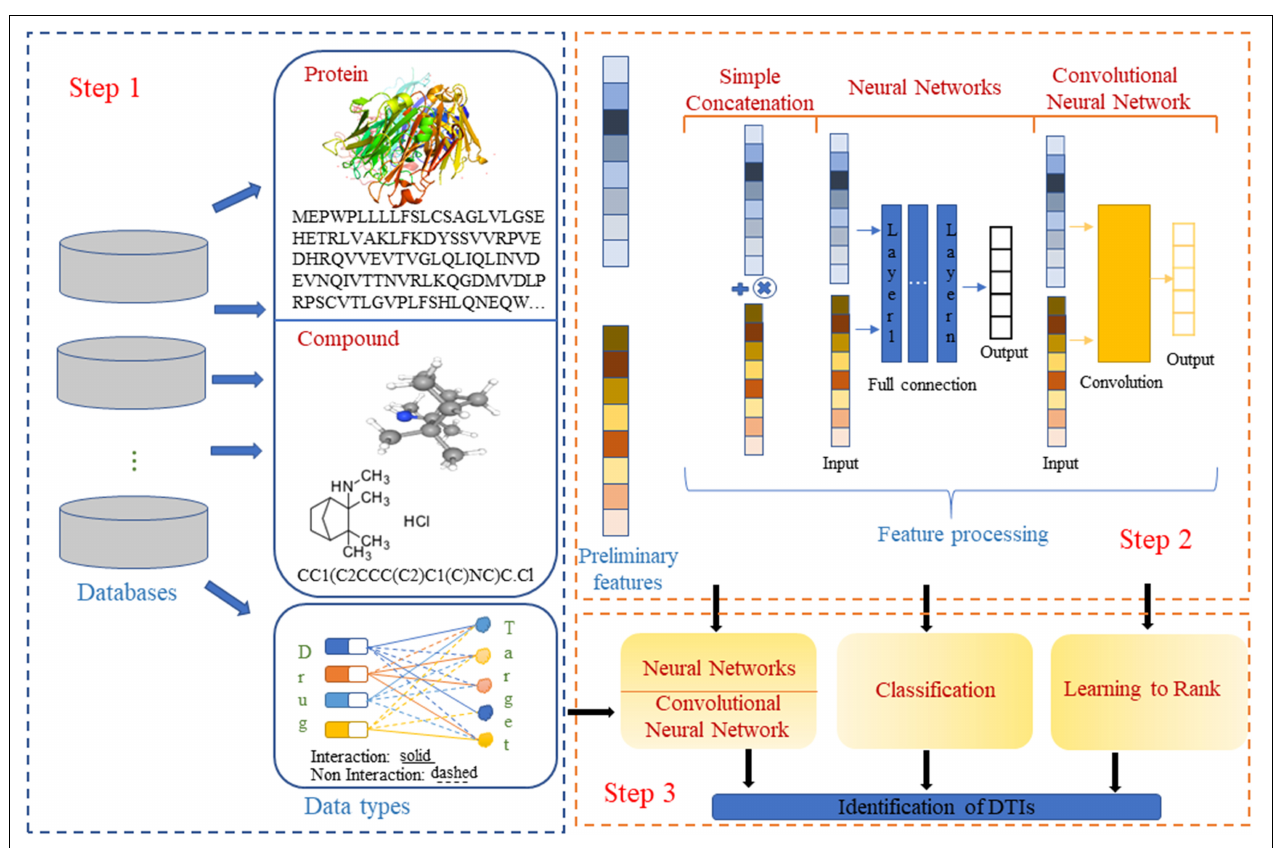
FIGURE 1 | Steps for predicting drug-target interactions. The two- and three-dimensional structure diagrams of the drug are from